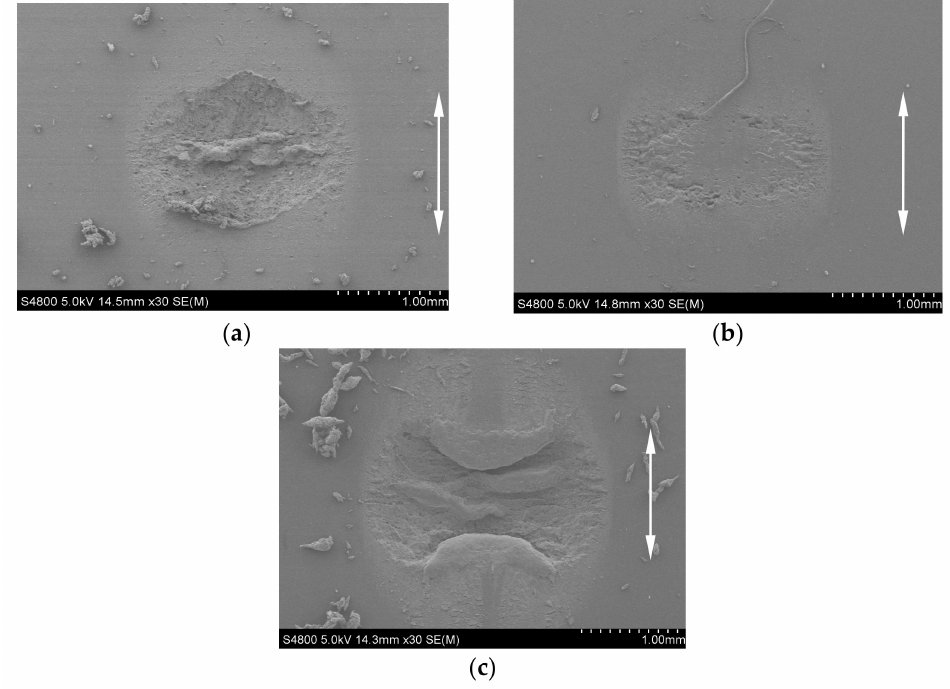
Figure 7. The SEM morphology of three rubbers under F n = 10 N, d = ± 0.45 mm, f = 10 Hz, H = 70 Ha, and N = 10 5 cycles: ( a ) FPM; ( b ) NBR; and ( c ) EPDM.